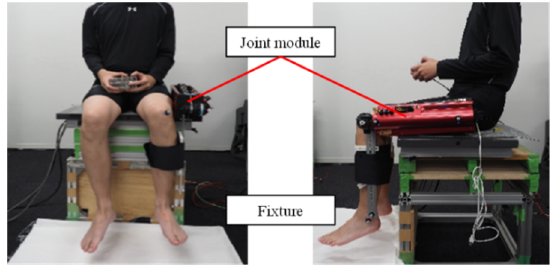
Figure 23. The appearance of a single joint training device that applies a Joint Module.